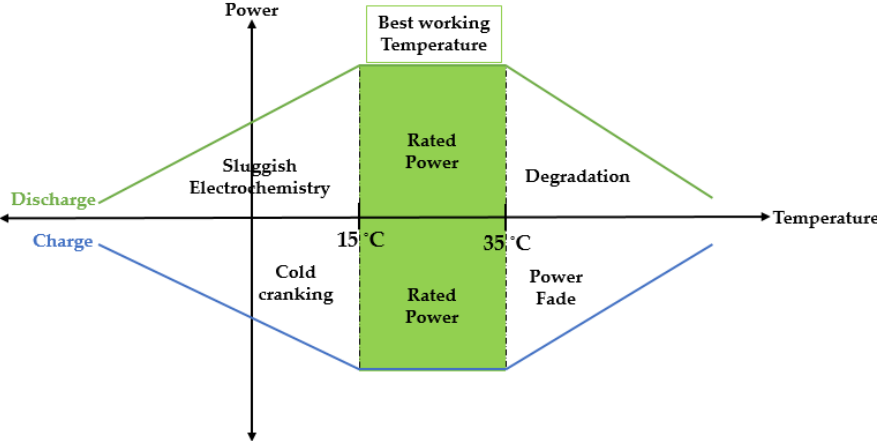
Figure 1. The operating temperature of the cell affects its lifetime, performance, and safety.